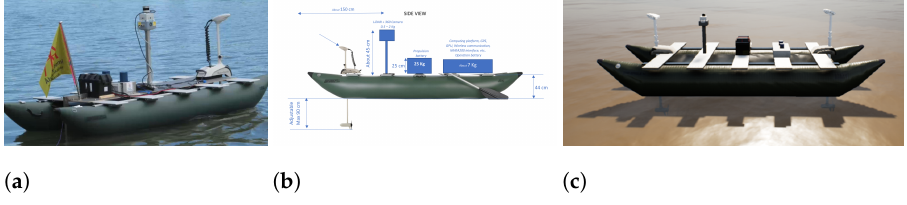
Figure 3. Åboat in real-world and AILiveSim simulation. ( a ) Åboat; ( b ) Side view of Åboat; ( c ) Åboat in